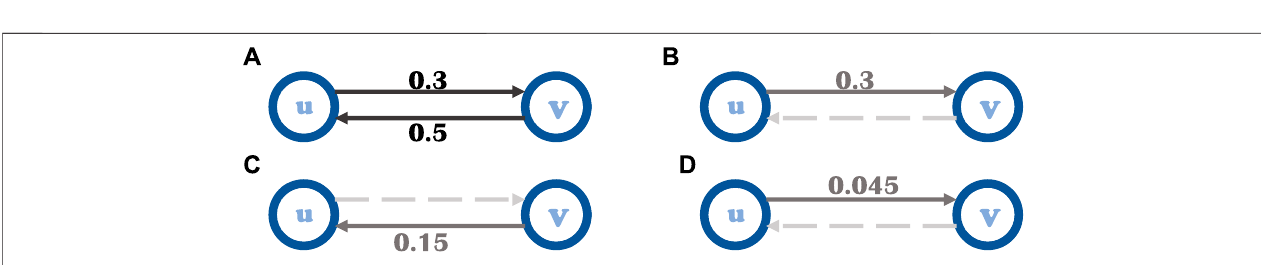
FIGURE3| Specialsituation inspreadingprocess. (A) Therearetwooppositesidesbetweennode u and v .Theprobabilityof u successfullyspreadinginformation to v is 0.3. And the probability from v to u is 0.5. (B) The probability from u to v is 0.3. (C) The probability from u to v to u is 0.15. (D) The probability of u to v passing through u - v - u - v is